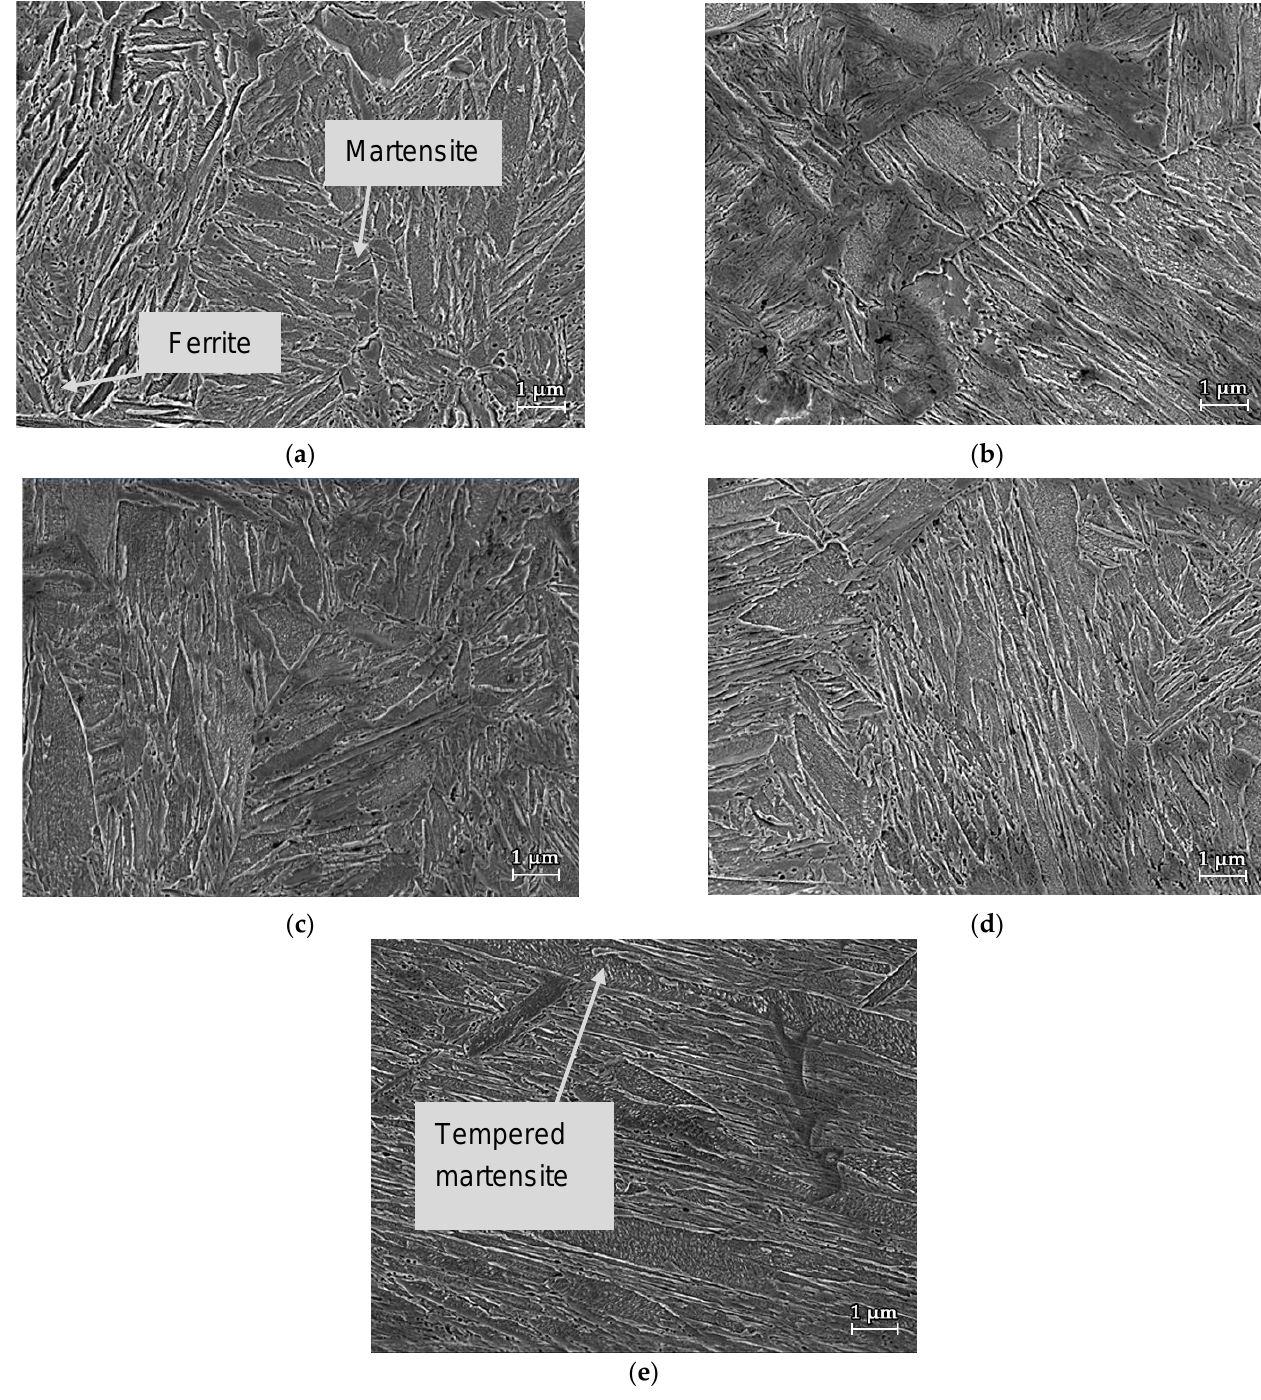
Figure 6. Microstructure of specimens obtained by SEM: T γ ( a ) 800 °C, ( b ) 900 °C, ( c ) 1000 °C, ( d ) 1100 °C, ( e ) 1200 °C.